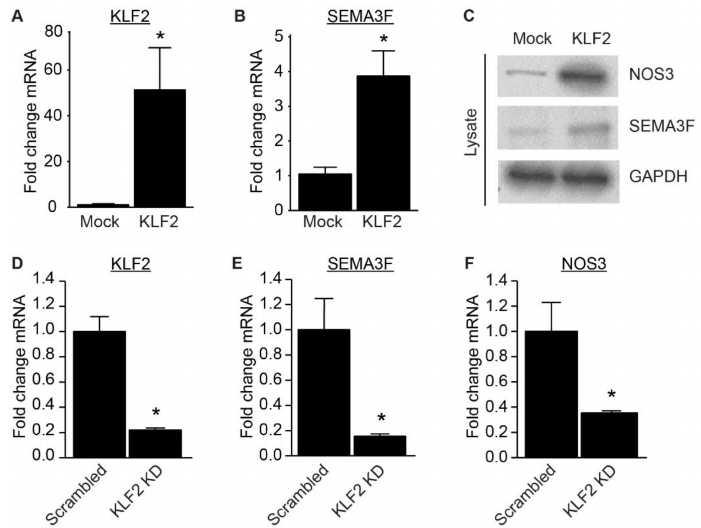
Figure 4. SEMA3F is induced by KLF2. ( A , B ) Quantitative qPCR analysis of KLF2 ( A ) and SEMA3F ( B ) mRNA isolated from HUVECs transduced with mock or KLF2 overexpressing lentivirus. Results are presented relative to cells transduced with mock virus, set as 1. Mean ± SEM of n = 3; * p < 0.05. ( C ) Representative immunoblot analysis of NOS3, SEMA3F or GAPDH in protein lysates of HUVEC transduced with mock or KLF2 overexpressing lentivirus. ( D – F ) KLF2 ( D ), SEMA3F ( E ) and NOS3 ( F ) mRNA expression in HUVECs after transduction with lentiviral anti-KLF2 shRNA (KLF2 KD) or scrambled shRNA (scrambled) and cultured under laminar flow conditions (10 dyn / cm 2 ) for 7 days compared to static culture conditions. Results are presented relative to scrambled, set as 1. Mean ± SEM of n = 3, * p <